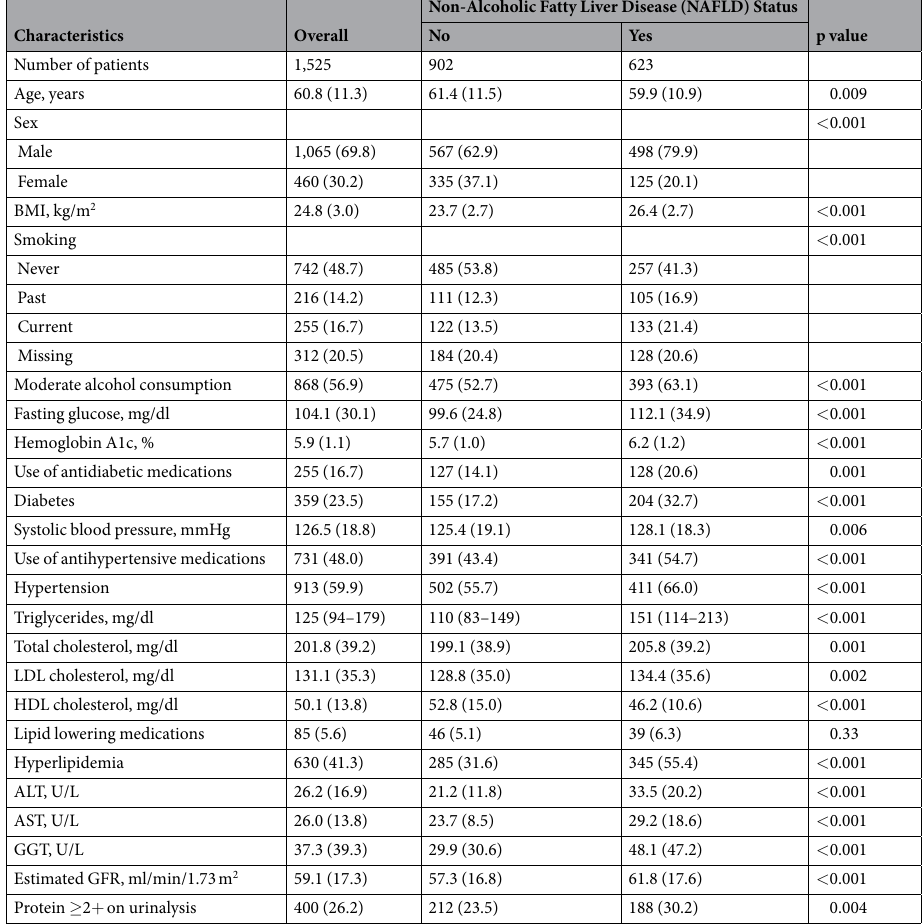
Table 1. Baseline characteristics of study population. Values are mean (SD), number (%), or median (interquartile range). ALT, alanine aminotransferase; AST, aspartate aminotransferase; BMI, body mass